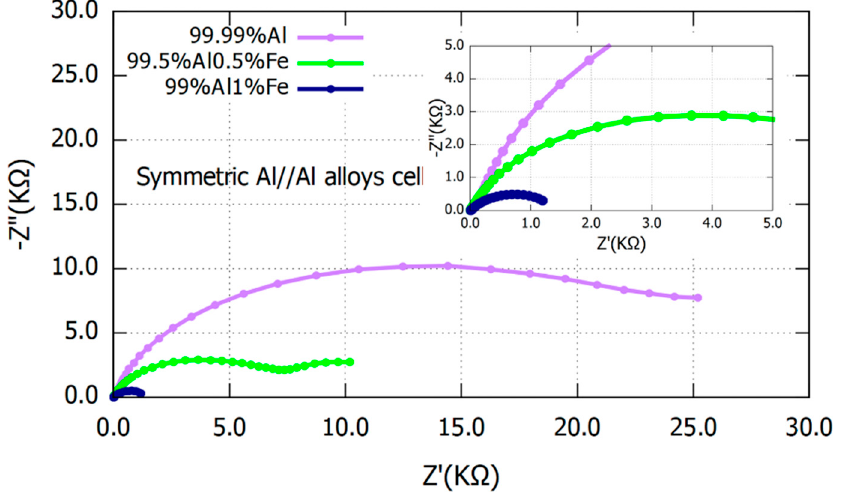
Figure 3 . Electrochemical impedance spectra (EIS) for symmetrical cells of 99.99% Al, 99.5% Al 0.5% Fe, and 99% Al 1%